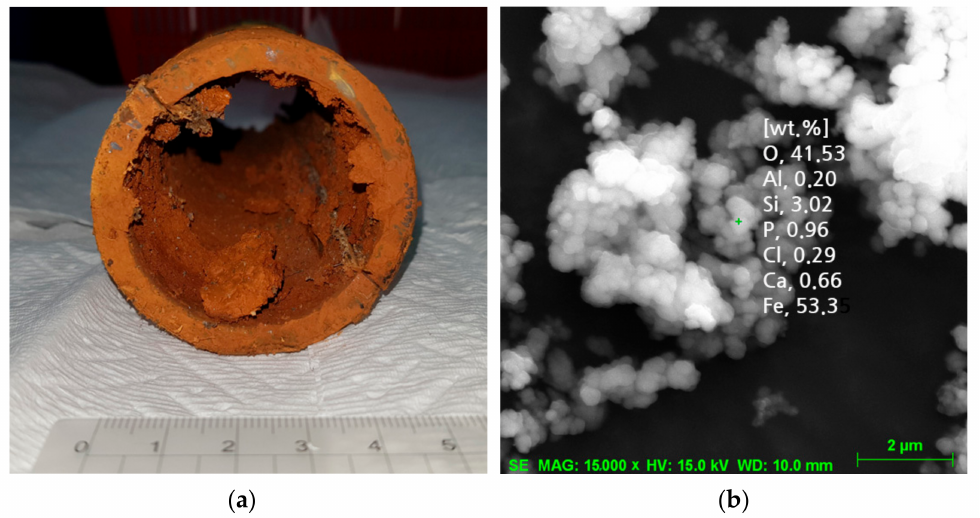
Figure 9. SEM-EDS analysis result for the material deposited inside the pipe of the D-8 well, ( a ) Brown- colored substances inside the pipe, and ( b ) SEM electron image for the deposit, which is a typical, representative picture of the particles that make up the sample. The green + is the point where chemical analysis was